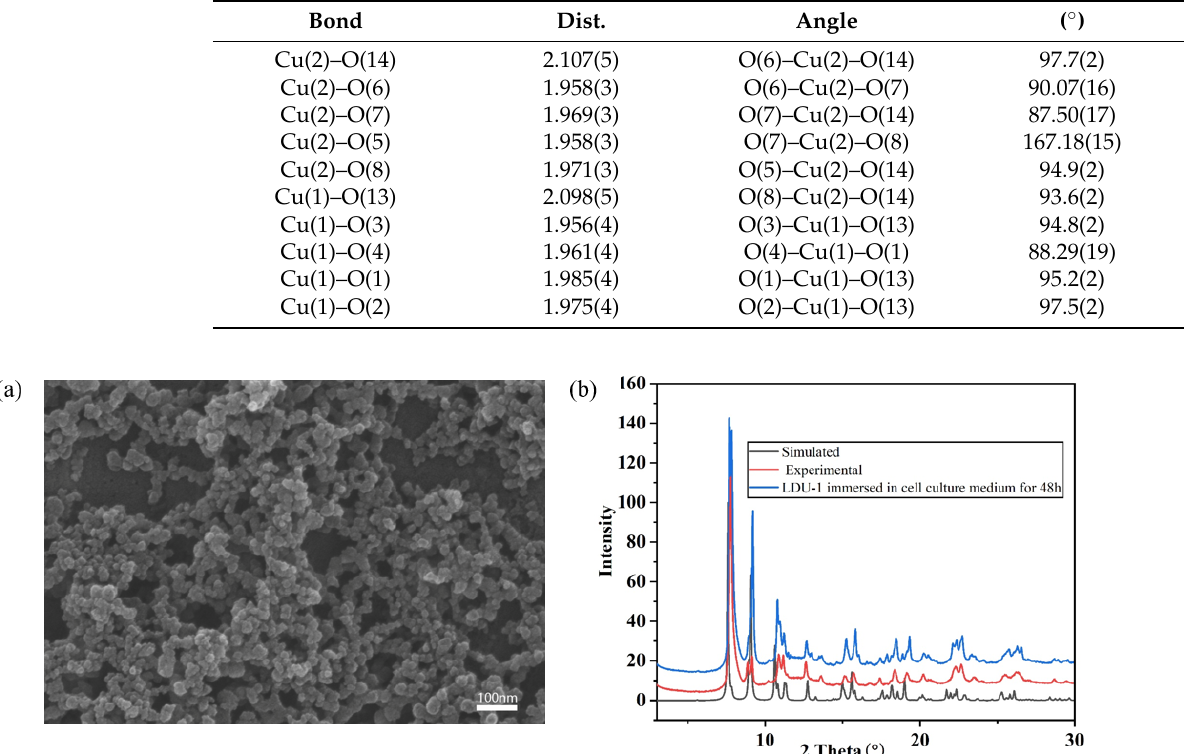
Table 2. Selected bond lengths (Å) and angles ( ◦ ) for LDU-1.